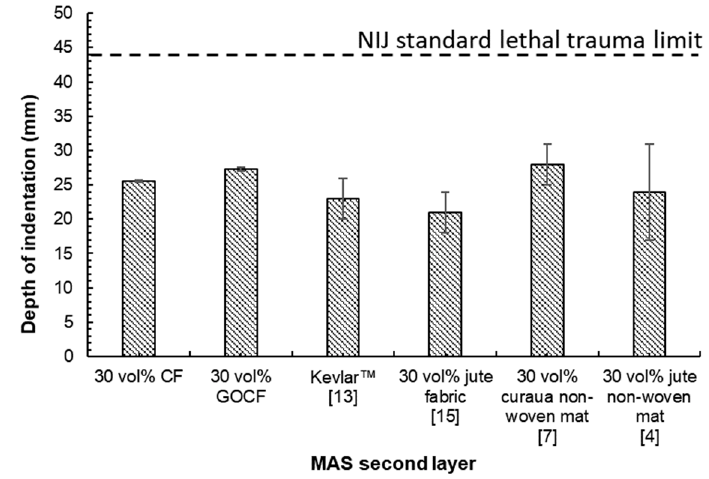
Figure 12. Depth indentation in clay witness of the reinforced composites with 30 vol%.